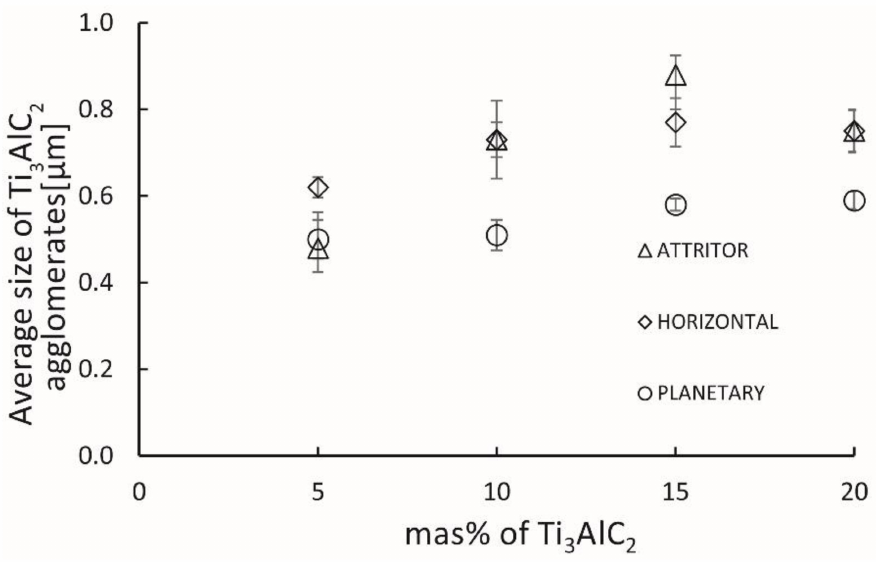
Figure 8. Average grain size of Ti 3 AlC 2 agglomerates in Al 2 O 3 -Ti 3 AlC 2